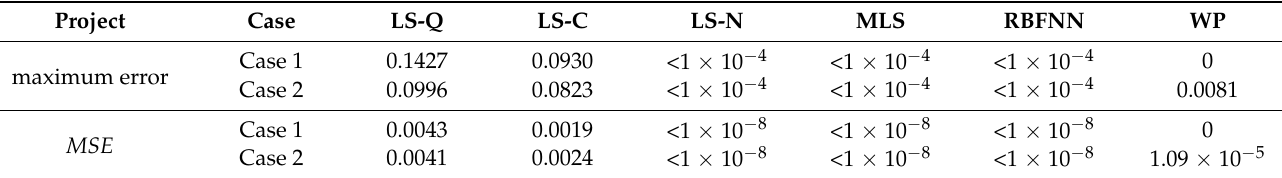
Table 1. Maximum error and MSE for TD1.